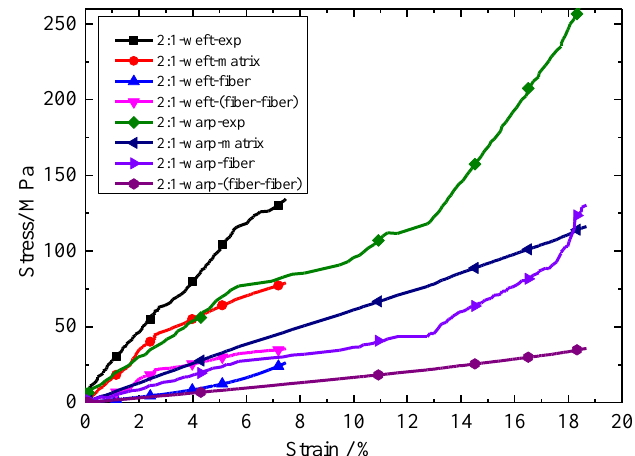
Figure 11. Relationship between each constituent of stress and experimental stress with strain under a stress ratio of 1.5:1 (warp:weft).